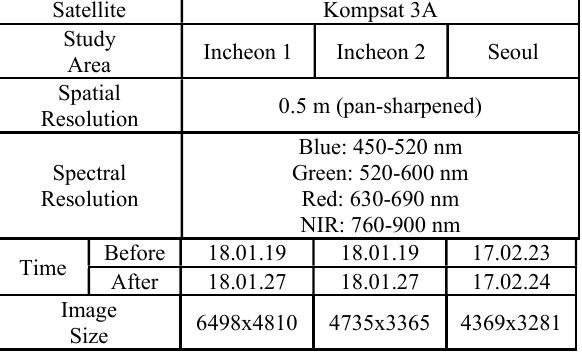
Table 1. specifications of Kompsat 3A Images.